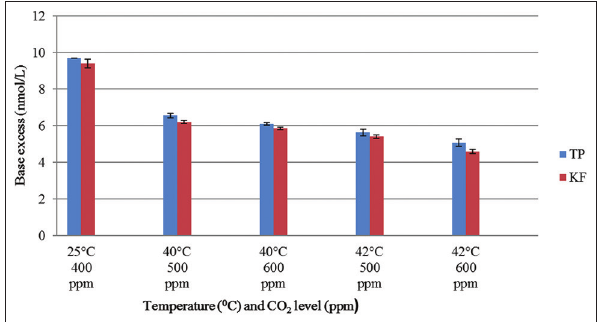
Figure-1: Effect of elevated temperature and CO on the base excess of Tharparkar and Karan Fries